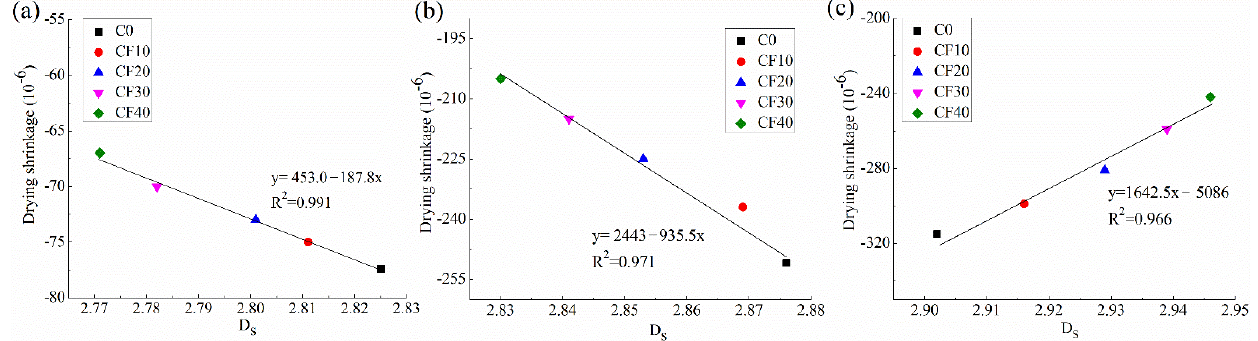
Figure 11. Correlations between drying shrinkage and D s at ( a ) 3 days, ( b ) 28 days and ( c ) 180 days.